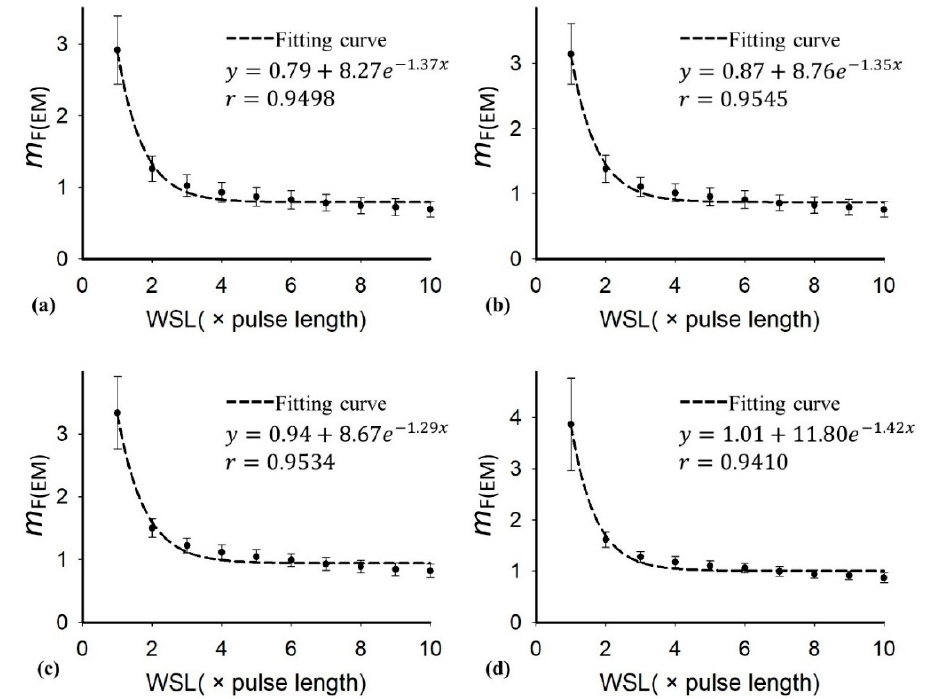
Figure 6. Average of the parameter m F(EM) in the ROI as a function of the WSL obtained with different grades of hepatic steatosis: ( a ) normal; ( b ) mild; ( c ) moderate; ( d ) severe. As the WSL increased, the parameter m F(EM) gradually decreased to exhibit a relatively stable estimation.